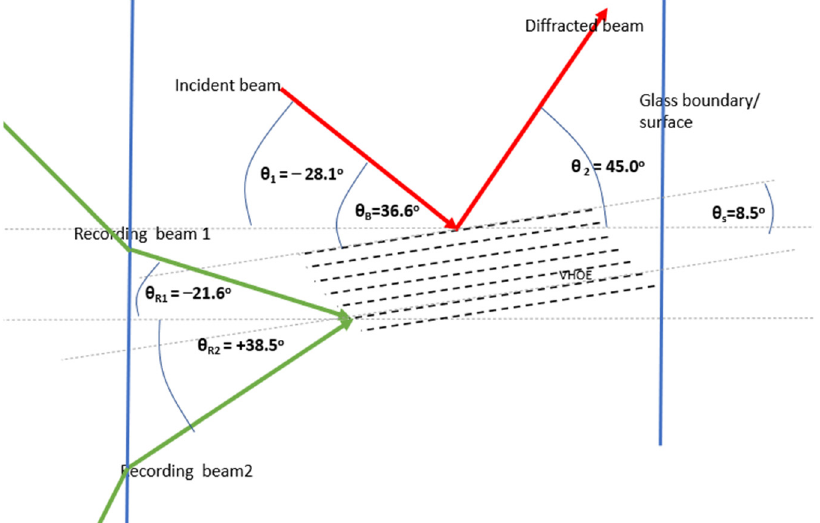
Figure 5. Recording beams of 532 nm (green arrows) needed for a grating designed to work as a coupler for 633 nm, and the incident and diffracted beams (red arrows) for operation at 633 nm. All angles shown are inside the medium.